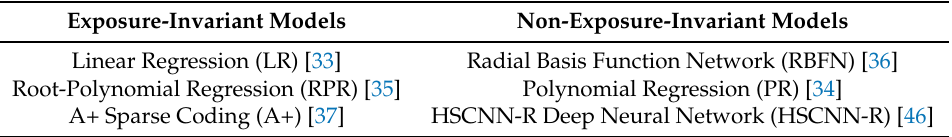
Table 1. Exemplar spectral recovery